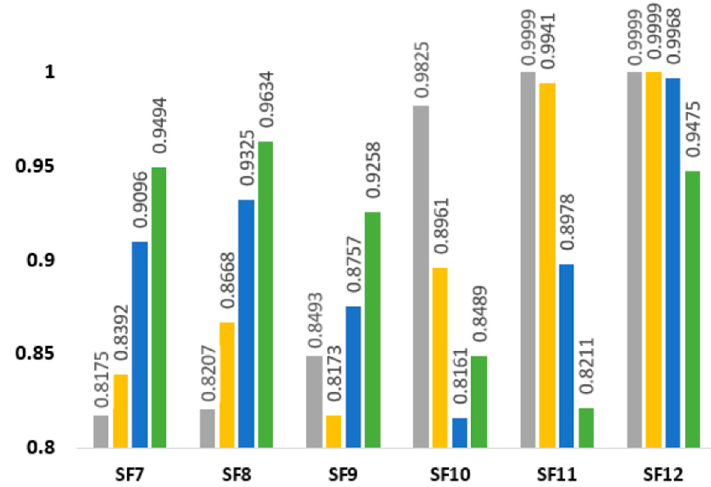
Figure 7. Multi-gateways using K-means MLA (125 kHz). Table 7. Multi-gateways based on K-means MLA.